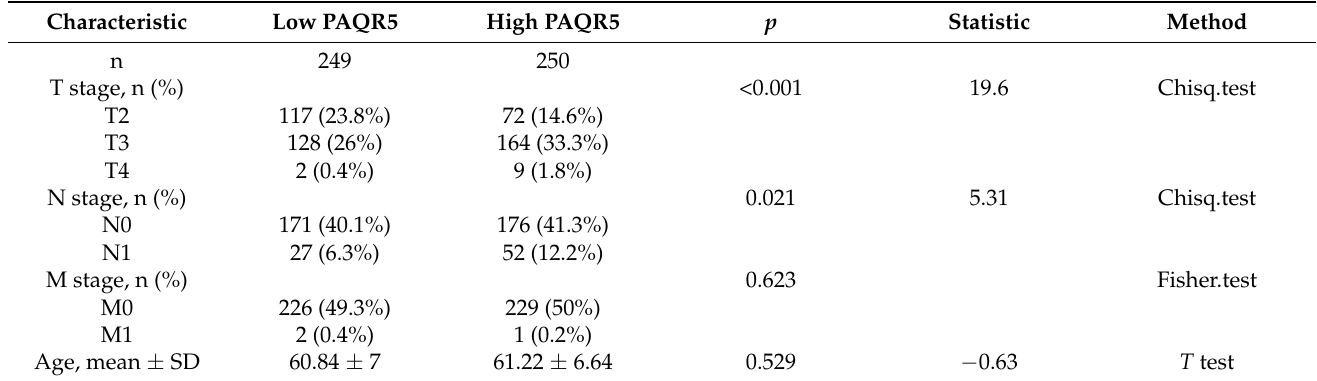
Table 2. Differences of PAQR5 Expression in TNM Categories of Prostate Cancers.